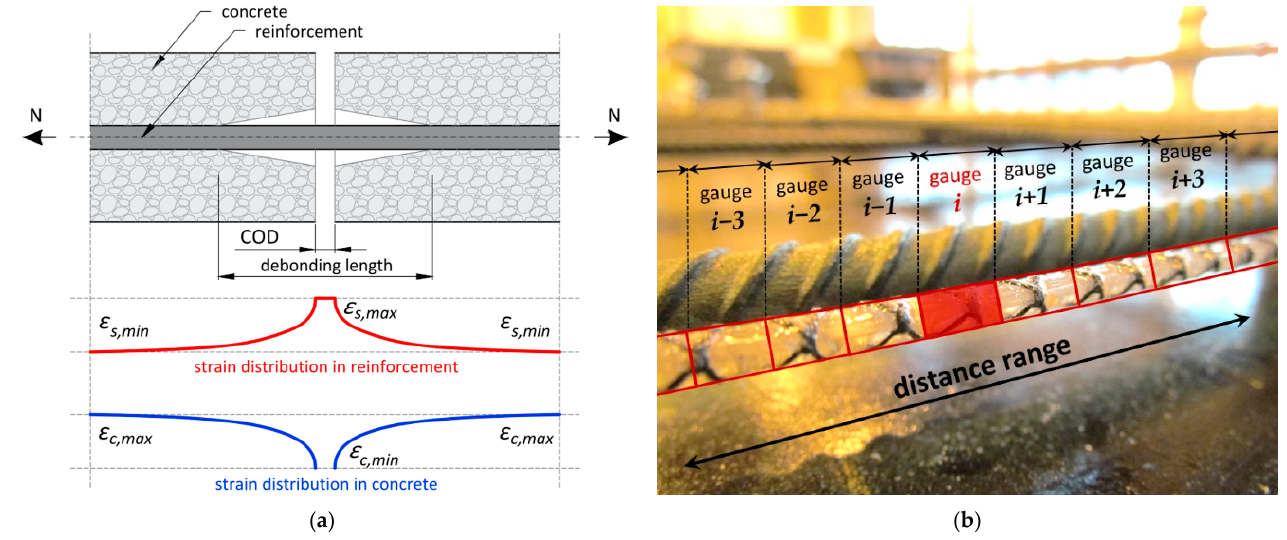
Figure 5. ( a ) Simplified scheme for a bond-slip crack model for reinforced concrete [51]; ( b ) simplified graphical interpretation of spatial resolution in distributed sensing.